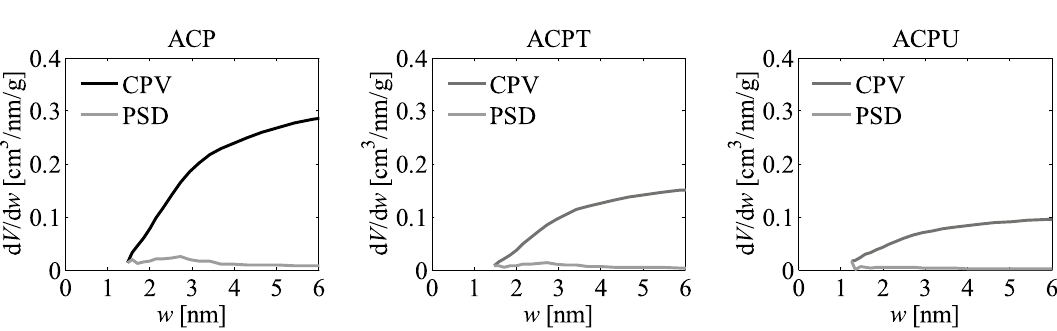
Figure 11. Pore size distributions (PSD) and cumulative pore volumes (CPV) obtained for the activated carbons developed with phosphoric acid activation and subjected to additional thermal (ACPT) and chemical (ACPU) treatments, by applying the QSDFT method to the corresponding nitrogen adsorption